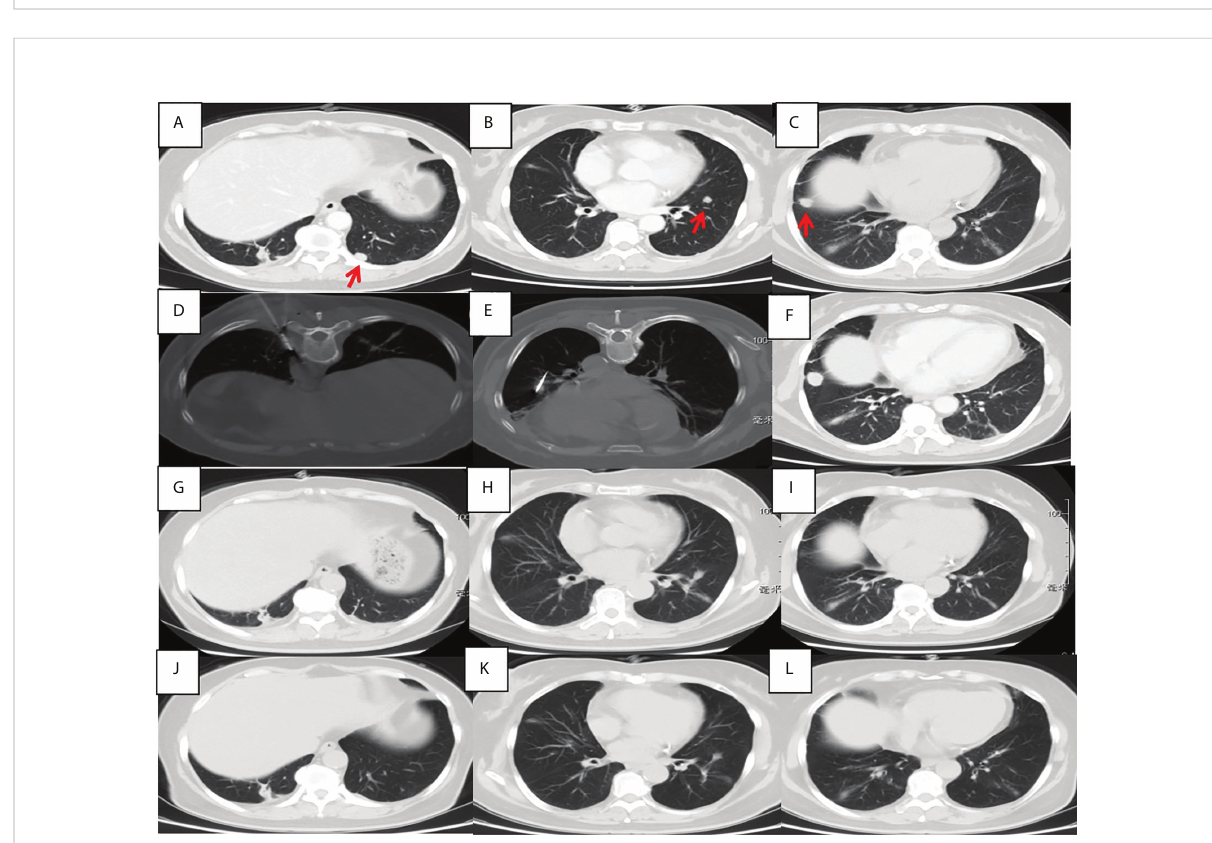
FIGURE 2 Chest CT fi ndings of a 56-year-old female pulmonary adenocarcinoma patient with an unknown PD-L1 TPS who underwent MWA and camrelizumab monotherapy. (A – C) Baseline chest CT showing two metastases in the left lower lobe. (D, E) MWA was conducted for the tumor in the left lower lobe. (F) Two cycles of camrelizumab monotherapy were administered, after which the right metastasis enlarged. (G – I) Six months post-ablation, the left metastases achieved complete ablation and the right metastasis disappeared; complete response was achieved. (J – L) Nineteen months post-ablation, there was no indication of any pulmonary metastases. PD-L1, programmed death ligand-1; TPS, tumor proportion score; MWA, microwave ablation; CT, computed